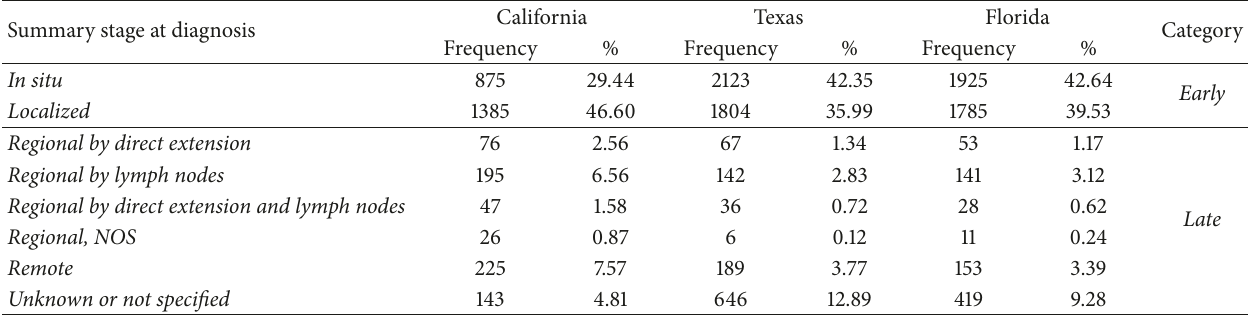
Table 1: Distribution of patient cases by summary stage, California, Texas, and Florida, 1996–2012. Summary stage at